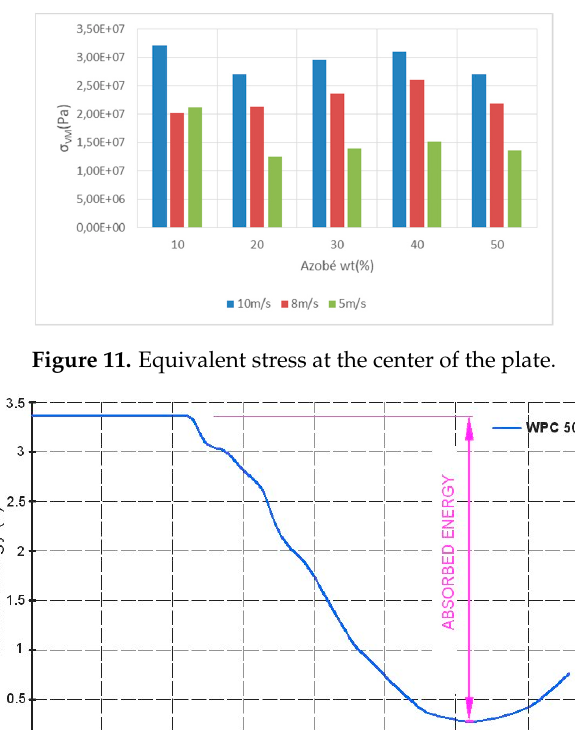
Figure 10. Maximum strains at the center of the plate.